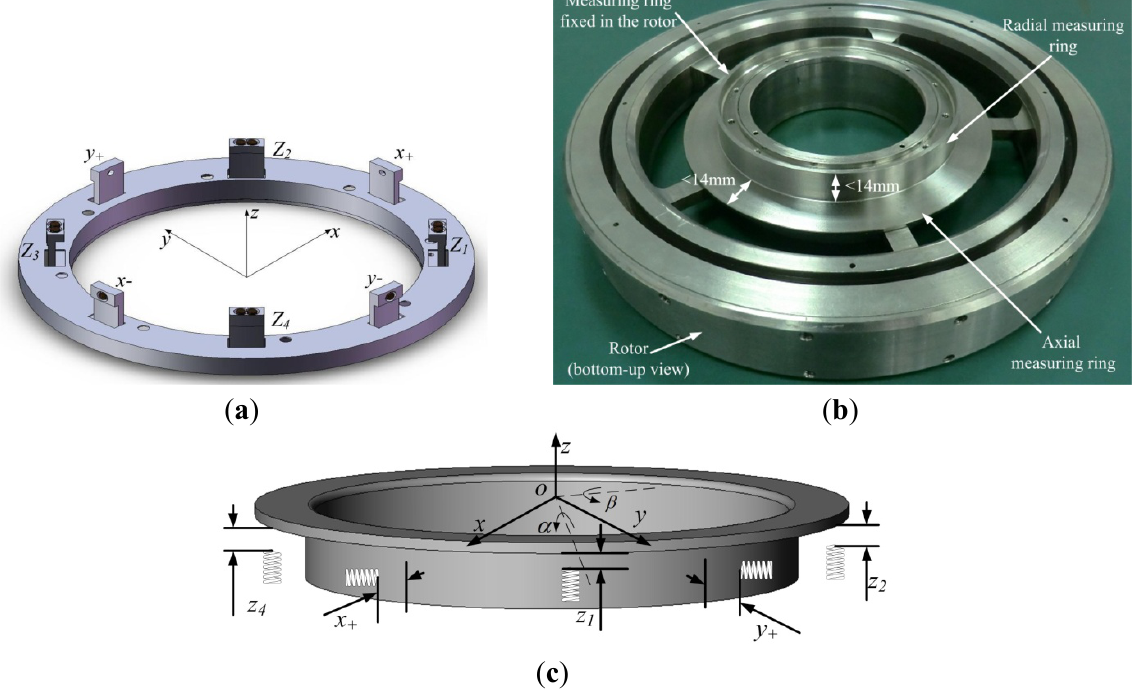
Figure 2. The 9-channel ECDS applied in the MSFW ( a ) The probe configuration of the 9-channel ECDS; ( b ) The measuring ring assembled in the rotor; ( c ) The relations between the generalized displacements of the rotor and the clearance lengths measured by the 9-channel